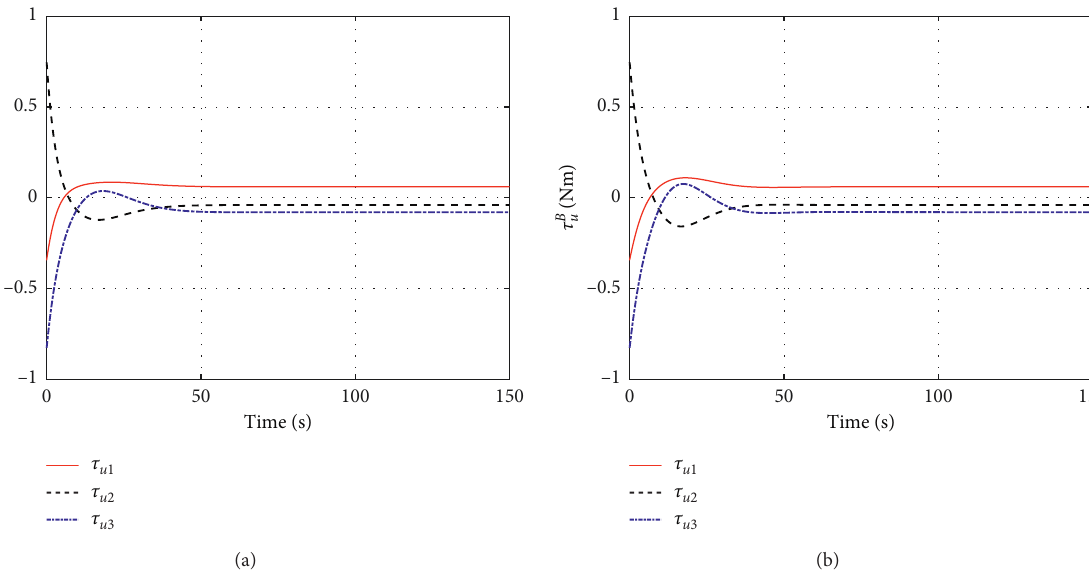
Figure 7: Control torque. (a) Proposed I&I adaptive controller. (b) CE-based adaptive